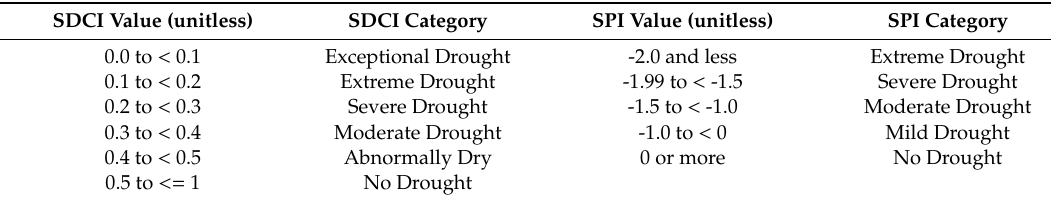
Table 1. Drought categories based on Scaled Drought Condition Index (SDCI, Rhee et al. [26]) and Standardized Precipitation Index (SPI, McKee et al. [46]).